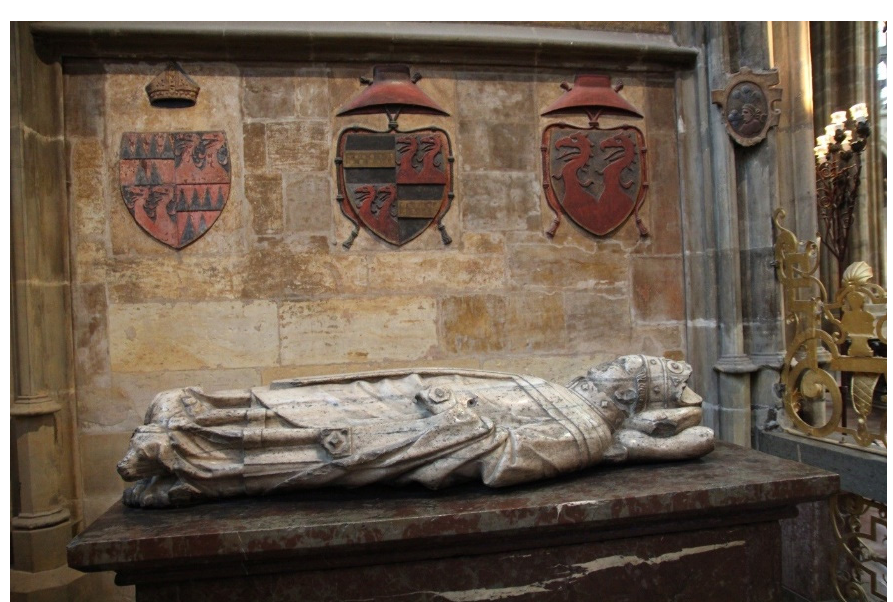
Figure 8. Spectrum of yellow massicot, zinc oxide.